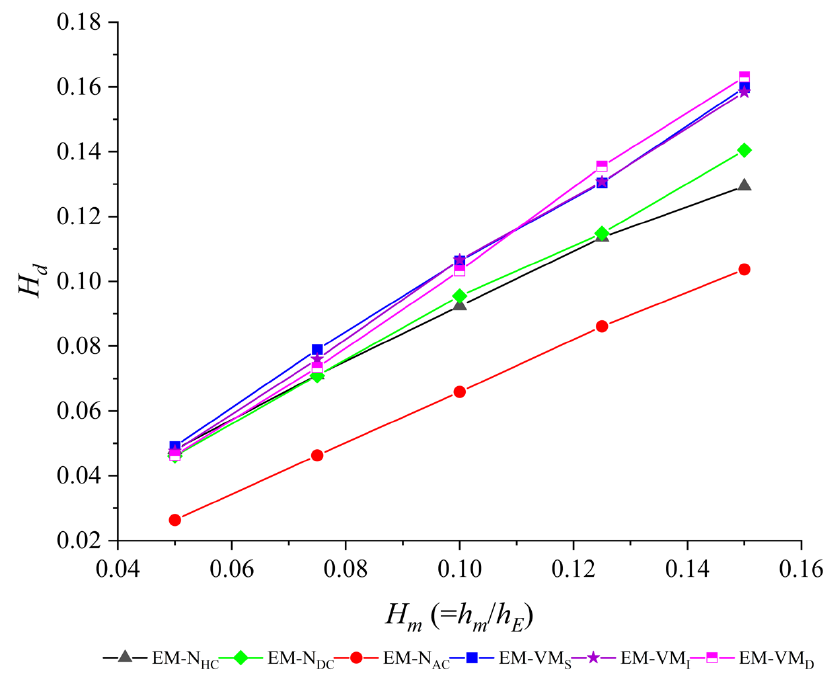
Figure 7. Normalized water downstream brink edge water depth ( H d ) against varying normalized overtopping depth ( H m ). 𝛥𝛥 𝑚𝑚